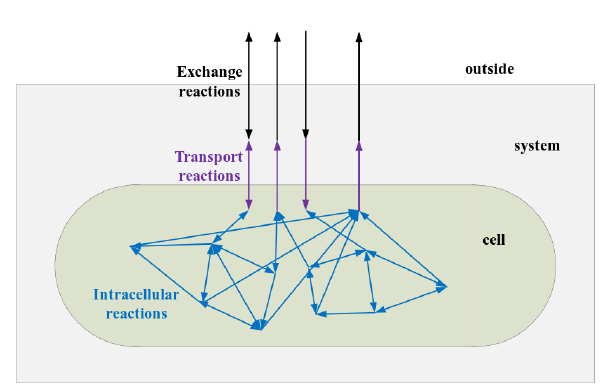
Figure A2. The catagories of reactions in the system. Exchange reactions are nutrient exchanges between system and outside. Tranport reactions are nutrient exchanges between cells and medium. Intracellular reactions are reactions whose reactants and products are both in